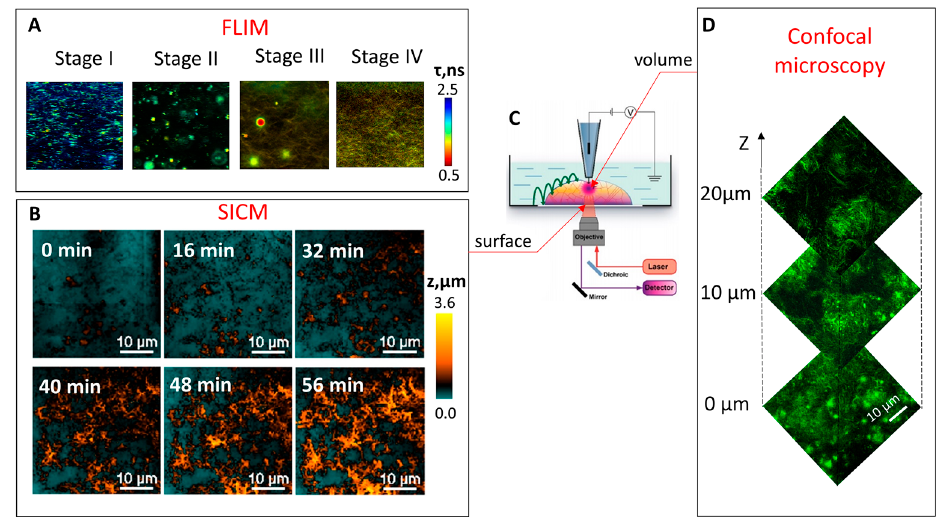
Figure 1. ( A ) FLIM images of the Fmoc-FF hydrogel formation at different stages in the presence of 40 µM ThT. Image size 80 × 80 µm 2 . ( B ) The process of Fmoc-FF self-assembly as revealed by SICM. ( C ) Schematic representation of areas in the sample from which by SICM and confocal microscopy images are obtained ( D ) Confocal microscopy Z-stack images of peptide Fmoc-FF aggregates.